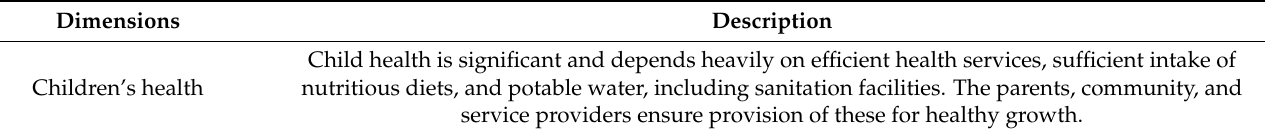
Table 2. National child-friendly community development core dimensions. Dimensions Description Children’s